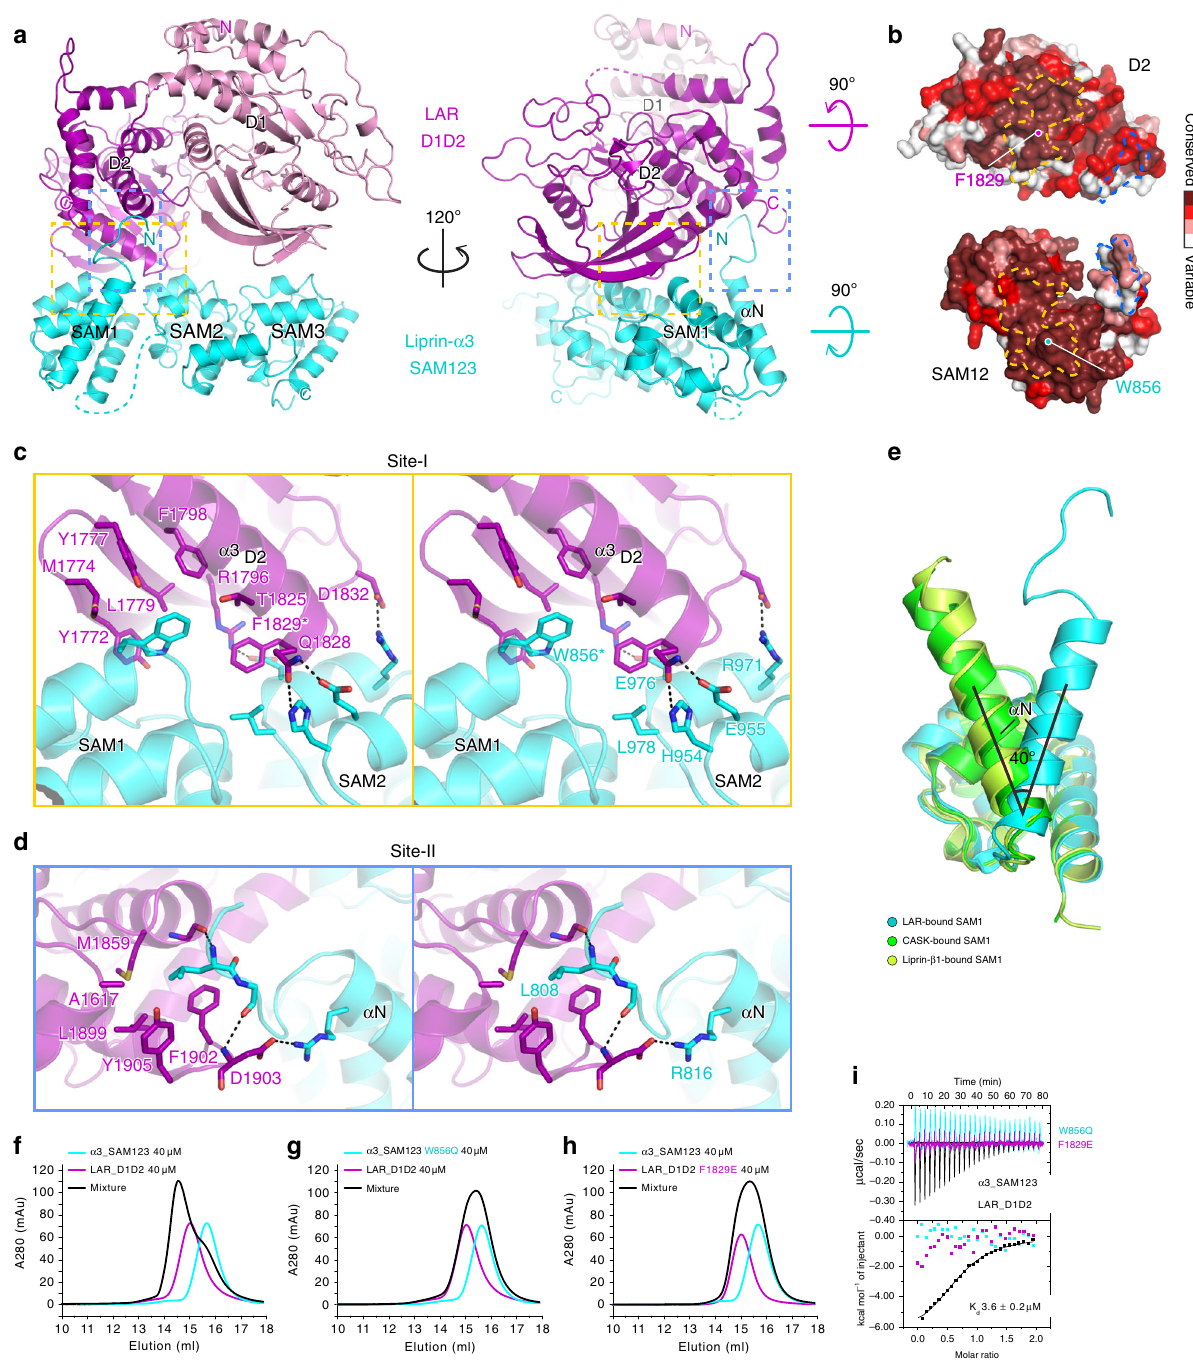
Fig. 2 Structural characterization of the liprin- α 3/LAR interaction. a Ribbon representations of the α 3_SAM123/LAR-D1D2 complex structure. The two binding sites were highlighted by dashed boxes. b Surface representations showing the high conservation of the two binding sites. c , d Stereoview of the atomic details of the two binding sites between α 3_SAM123 and LAR-D1D2, corresponding to the boxed regions shown in ( a ) with the same color. W856 in liprin- α 3 and F1829 in LAR, indicated by asterisks, play the key role in the liprin- α 3/LAR interaction. Hydrogen bonds and salt bridges are indicated by dashed lines. e Structural alignment of the SAM1 domains from the complex structures of α 3_SAM123/LAR-D1D2, α 2_SAM123/CASK_CaMK (PDB ID: 3TAC), and α 2_SAM123/ β 1_SAM123 (PDB ID: 3TAD) showing the orientation change of the α N-helix. f – h Analytical gel fi ltration analysis showing that either the W856Q mutation in liprin- α 3 or the F1829 mutation in LAR disrupts the liprin- α 3/LAR interaction. i ITC-based measurement of the binding of